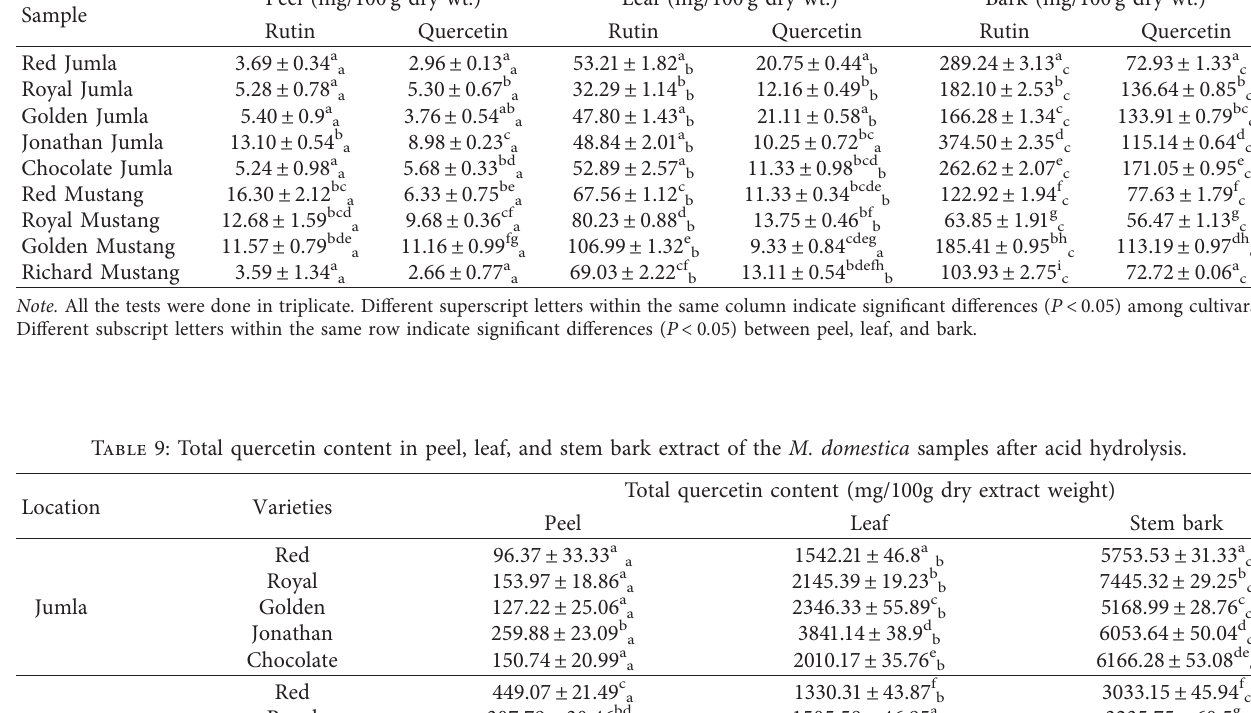
Table 8: Total rutin and quercetin content of peel, leaf, and bark of different M. domestica cultivars. Sample